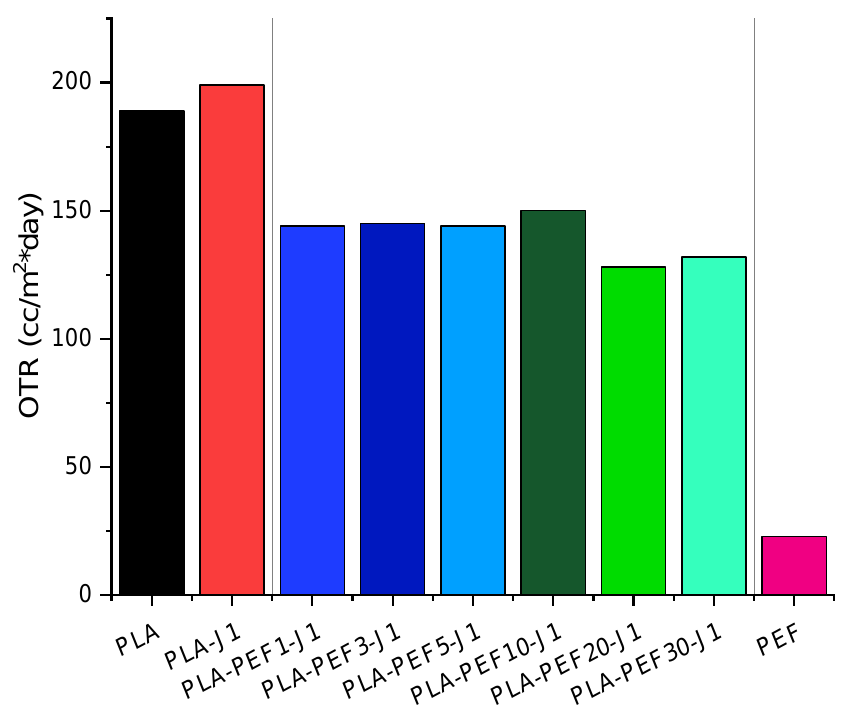
Figure 11. Results of the oxygen permeability test: values of the oxygen transmission rate (OTR) on some selected samples.